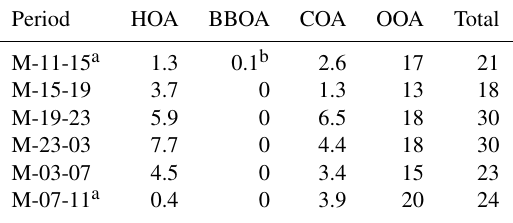
Table 1. Average seasonal concentrations of time-of-day PMF fac- tors for winter 2017 (in µgm − 3 ).